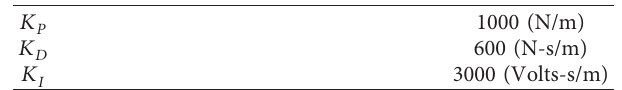
Table 2: Feedback control